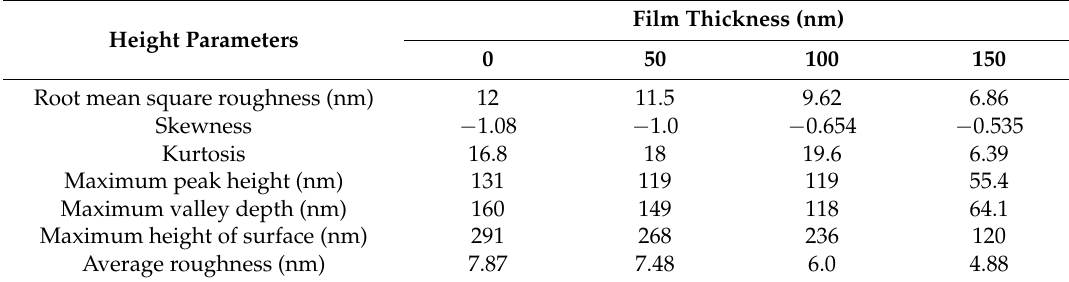
Table 3. Height parameters of the AFM analysis of the uncoated, 50 nm, 100 nm, and 150 nm coated SS